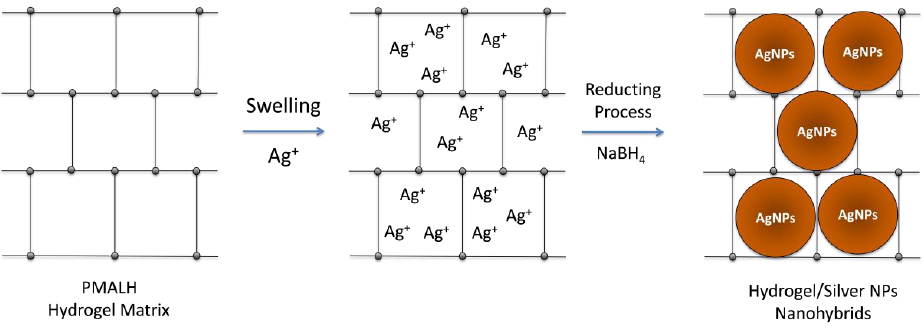
Figure 2. Preparation scheme of hydrogel / silver nanohybrids